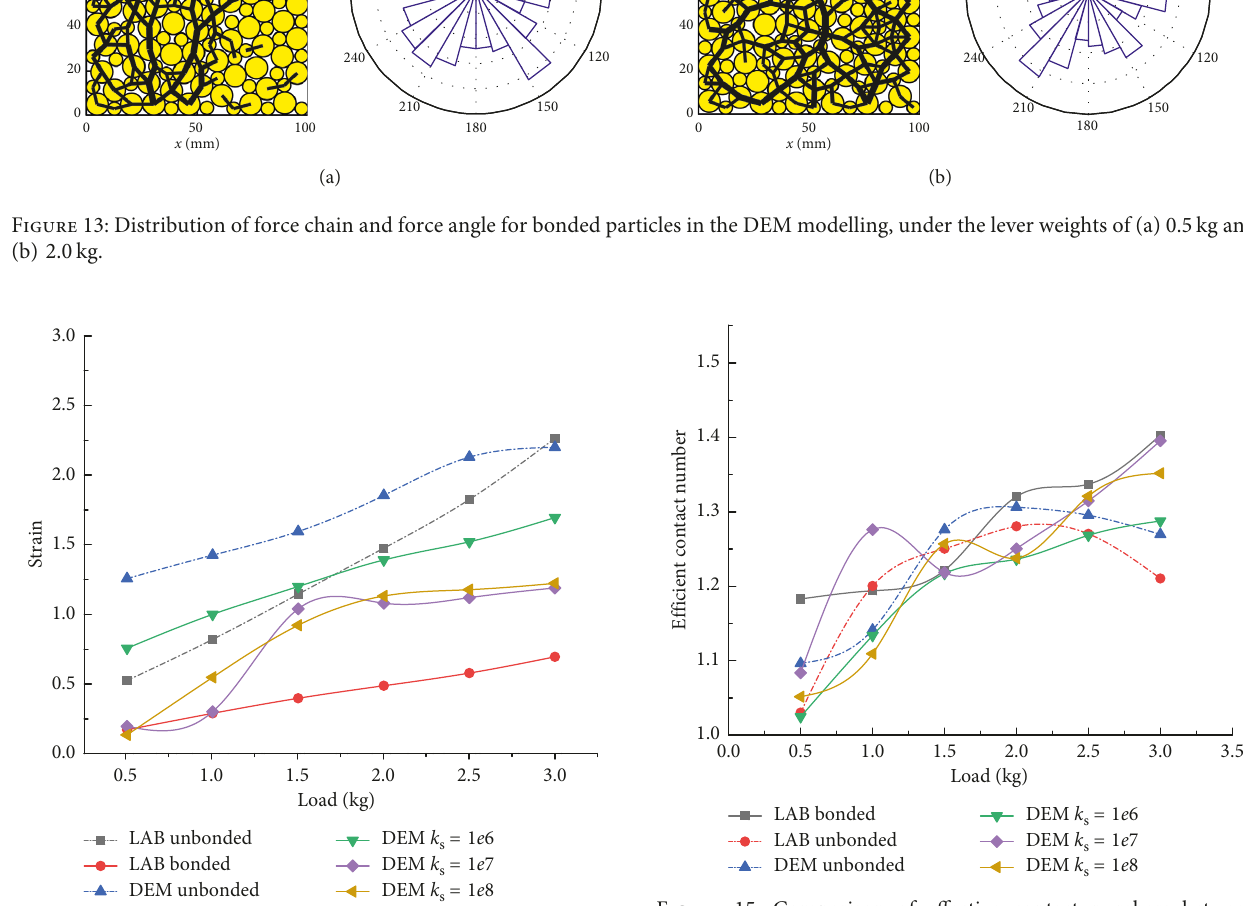
Figure 14: Comparison of strain evolution in both the photoelastic mode test and DEM modelling.